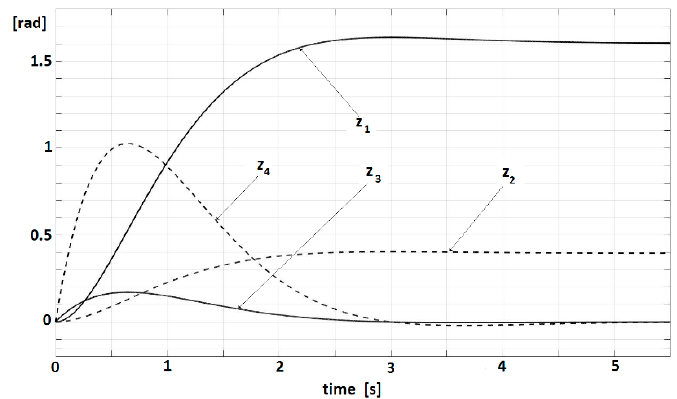
Figure 3. Frequency plots for Exoskeleton Glove model.